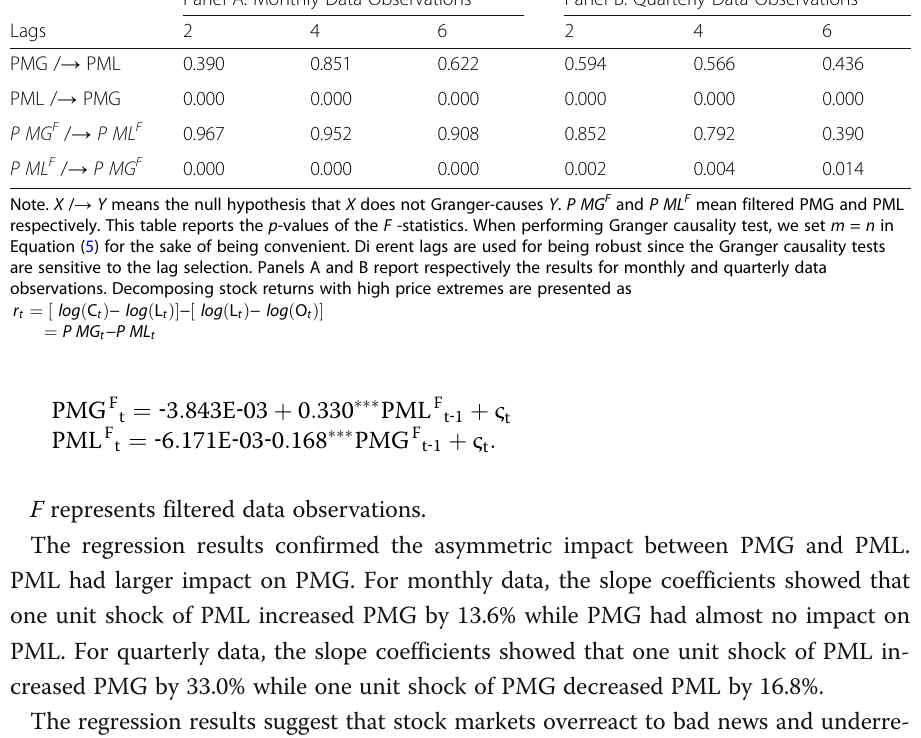
Table 6 Granger Causality Tests on PMG and PML. Decomposition with Low Price Extremes Panel A. Monthly Data Observations Panel B. Quarterly Data